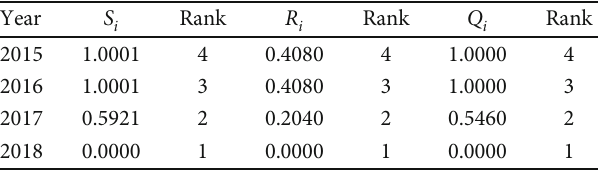
R Q i , i , and i value of environmental impact subsystem.